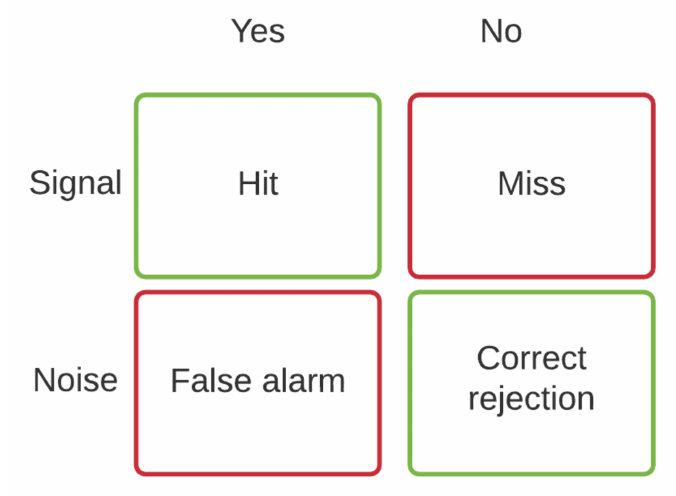
Figure 2. SDT answer